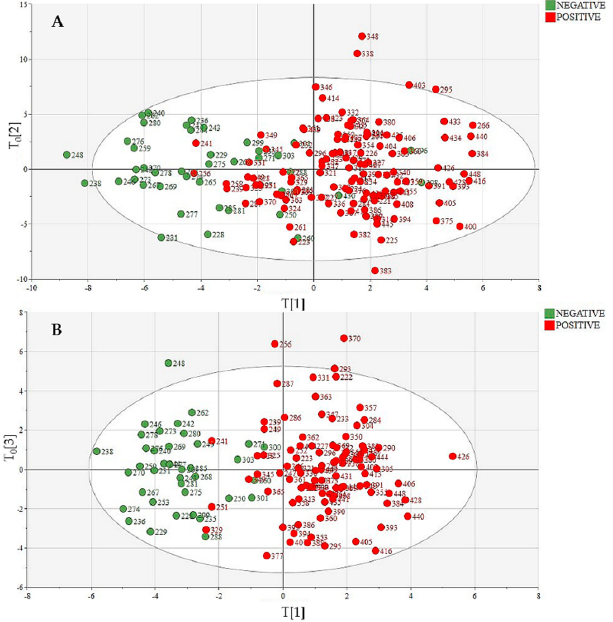
Figure 1. Orthogonal partial least squares discriminant analysis (OPLS-DA) of ( A ) all of the data ( n = 164) color coded by RT-PCR test result comparing positive patients ( n = 193) and negative patients ( n = 41) and ( B ) only taking into account positive patients who were sampled within 14 days of the positive RT-PCR test ( n = 97), and removing patients who were recovering from COVID-19 leaving only negative patients with no known history of COVID-19 ( n = 37).